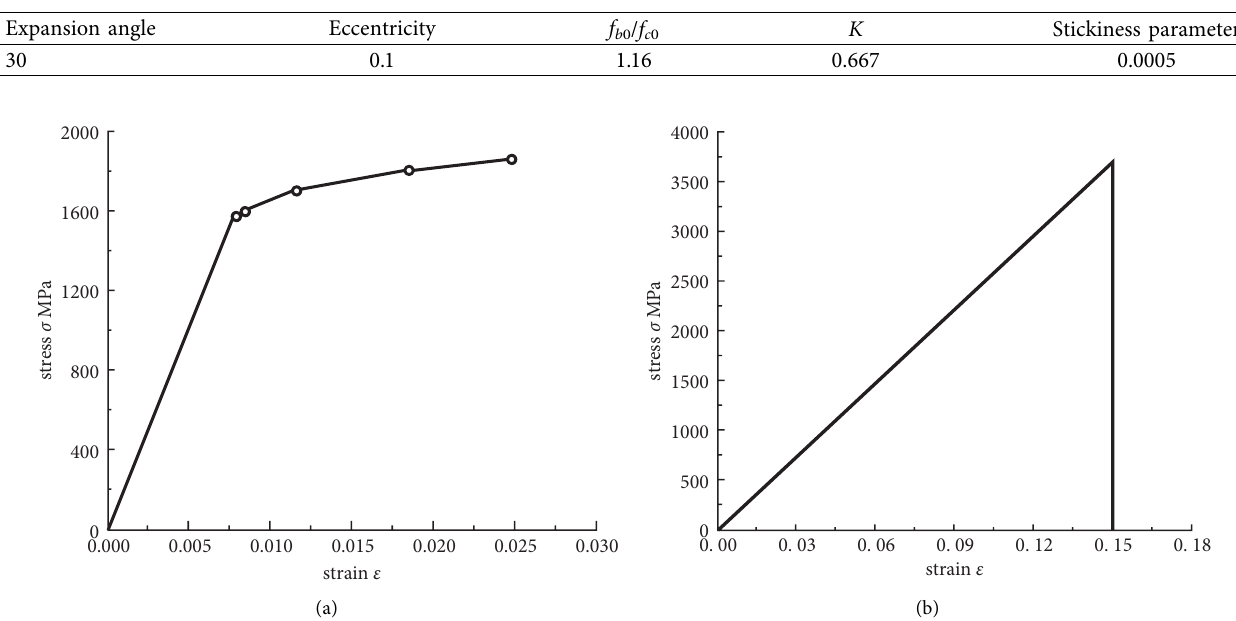
Figure 16: Stress distribution diagrams. (a) Section. (b) Strain distribution. (c) Stress distribution. Table 5: Plastic damage parameter.